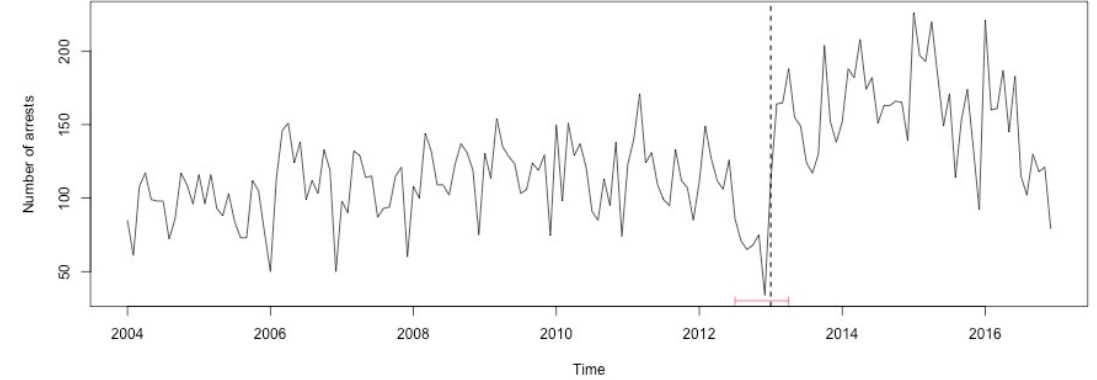
Figure A26. Methamphetamine arrests 2004–2016 in the Czech Republic and structural breaks.